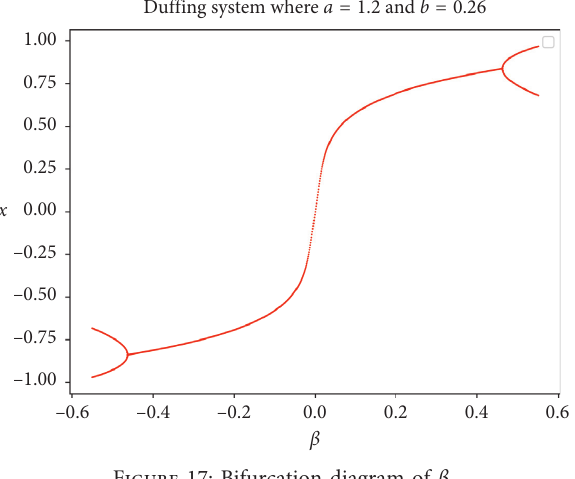
Figure 20: Time series diagram.